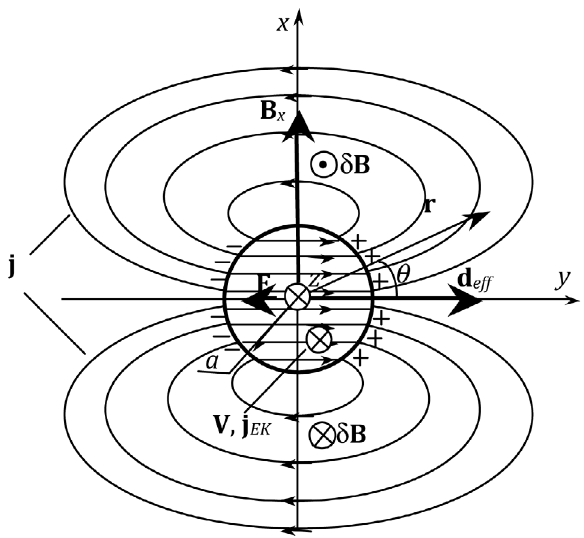
Figure 1. A geometry of the magma flow model and schematic configuration of total currents j flowing across a volcano throat. The magma velocity V is directed along z axis. The effective cur- rent moment d is perpendicular to V and geomagnetic field B . ef f Circles with dots and crosses indicate the directions of magnetic disturbance d B and magma